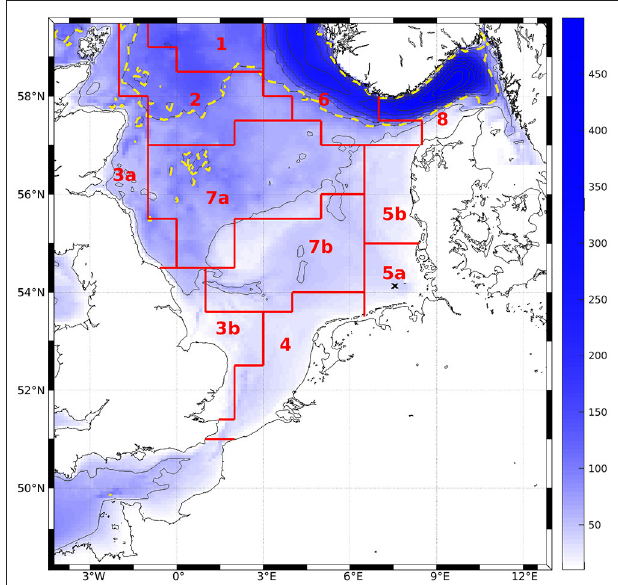
FIGURE 3 | Bathymetry of the model area. Contour intervals are 50 m, dashed line denotes 100 m. Red lines and tags show ICES boxes after O’Driscoll (2014). The black cross marks the station to which Figures 4 and 7